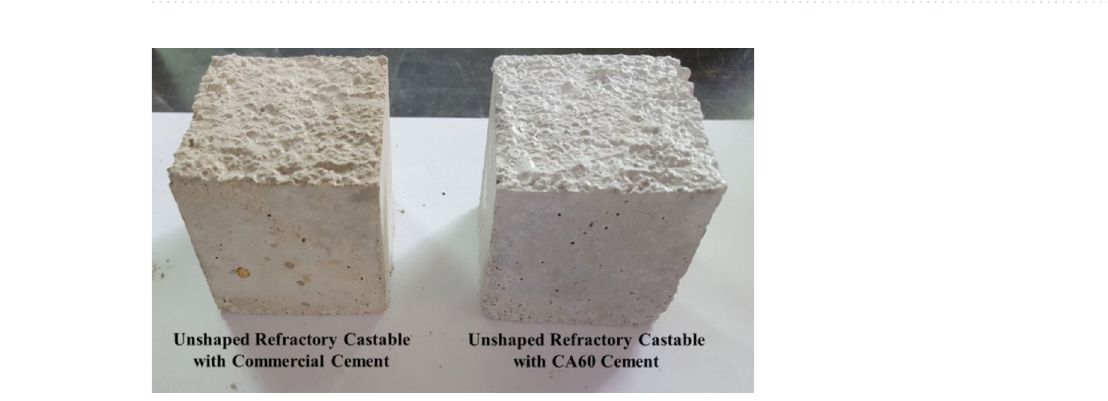
Figure 11. Cold crushing strength of the hydrated CA60 cement samples sintered at 1450 °C after 1, 3, 7, and 28 days of hydration.